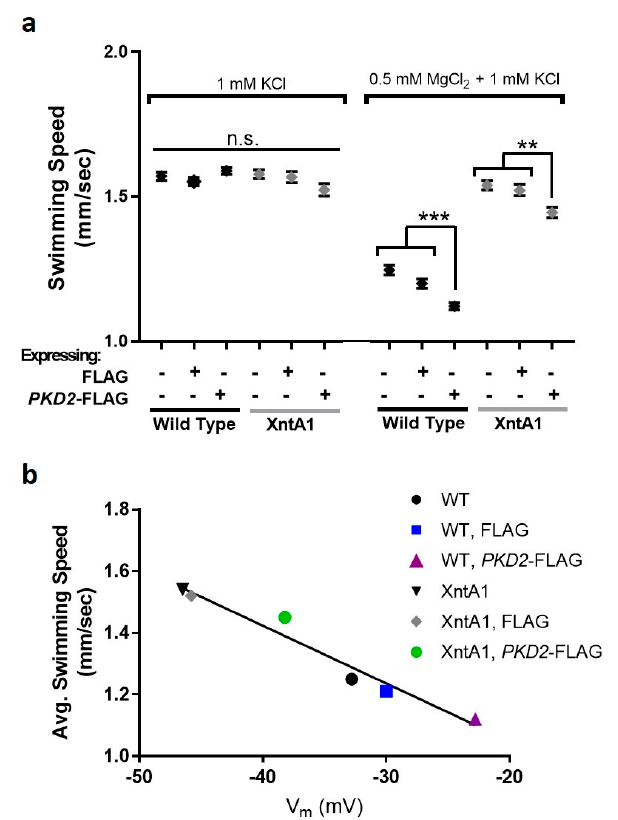
Figure 8. Over-expression of PKD2 -FLAG significantly slows swimming speed in 0.5 mM MgCl 2 with 1 mM KCl and average swimming speed is correlated with V m . ( a ) No significant di ff erence (n.s.) is observed between wild type (WT), XntA1 mutants, or cells expressing FLAG or PKD2 -FLAG when entering 1 mM KCl from 1 mM KCl. When cells enter 0.5 mM MgCl 2 with 1 mM KCl from 1 mM KCl, WT and WT cells expressing FLAG significantly slow their swimming speed compared to entering 1 mM KCl. WT cells over-expressing PKD2 -FLAG show significantly slower swimming than the WT or WT over-expressing FLAG in the Mg 2 + solution (*** = p < 0.0001, T-test). XntA1 mutants and XntA1 mutants expressing FLAG do not change their swimming speed when entering 0.5 mM MgCl 2 with 1 mM KCl from 1 mM KCl. Over-expression of PKD2 -FLAG in the XntA1 mutants results in significantly slower swimming speeds compared to XntA1 and XntA1 expressing FLAG (** = p < 0.01, T-test). All data are average swimming speed in mm / sec ± SEM, N = 134–820 traces, each cell type was tested at least three separate times. ( b ) The swimming speed of the cells in 0.5 mM MgCl 2 with 1 mM KCl is correlated with the membrane potential of cells in the same solution, linear regression R 2 = 0.96.